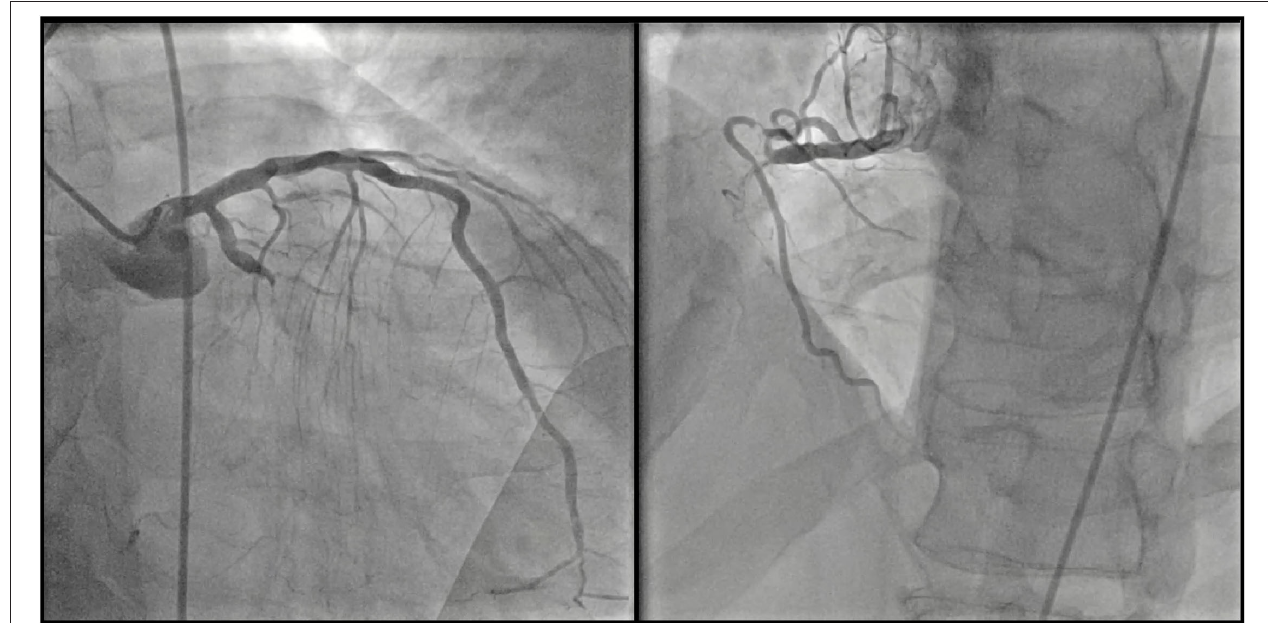
FIGURE 1 | Coronary angiography. Left panel : chronic total occlusion of the mid left circumflex coronary artery. Right panel : chronic total occlusion of the proximal right coronary